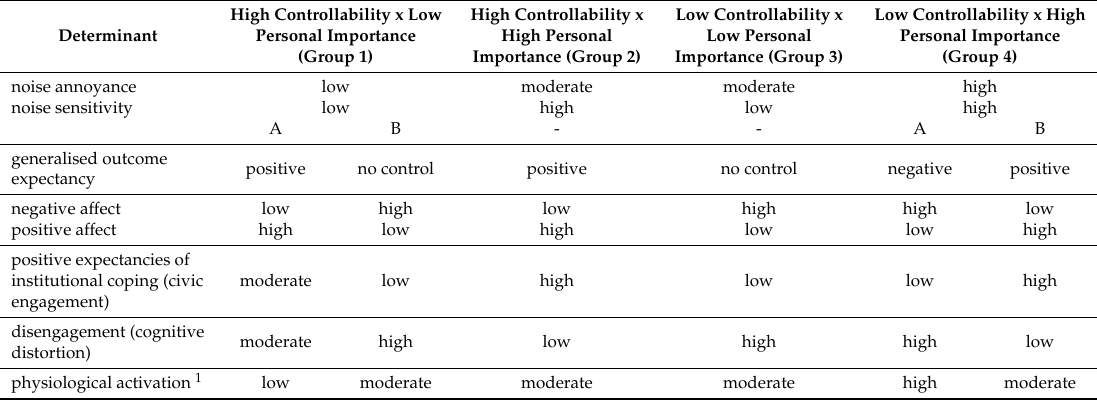
Table 1. Hypothetical patterns of cognitive-motivational determinants, noise annoyance, and sustained physiological activation within four